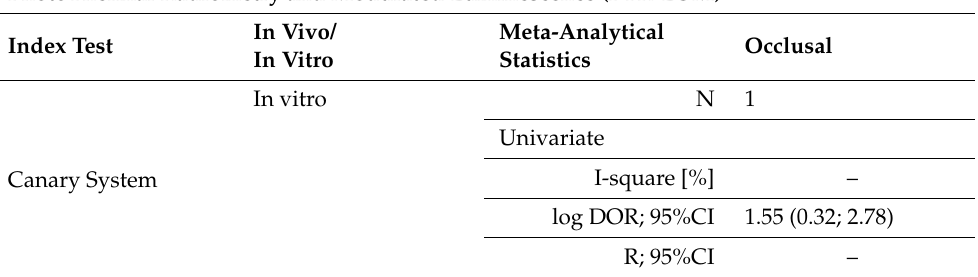
Table 12. Descriptive results for the photo-thermal radiometry and modulated luminescence (PTR- LUM) technology, Canary System